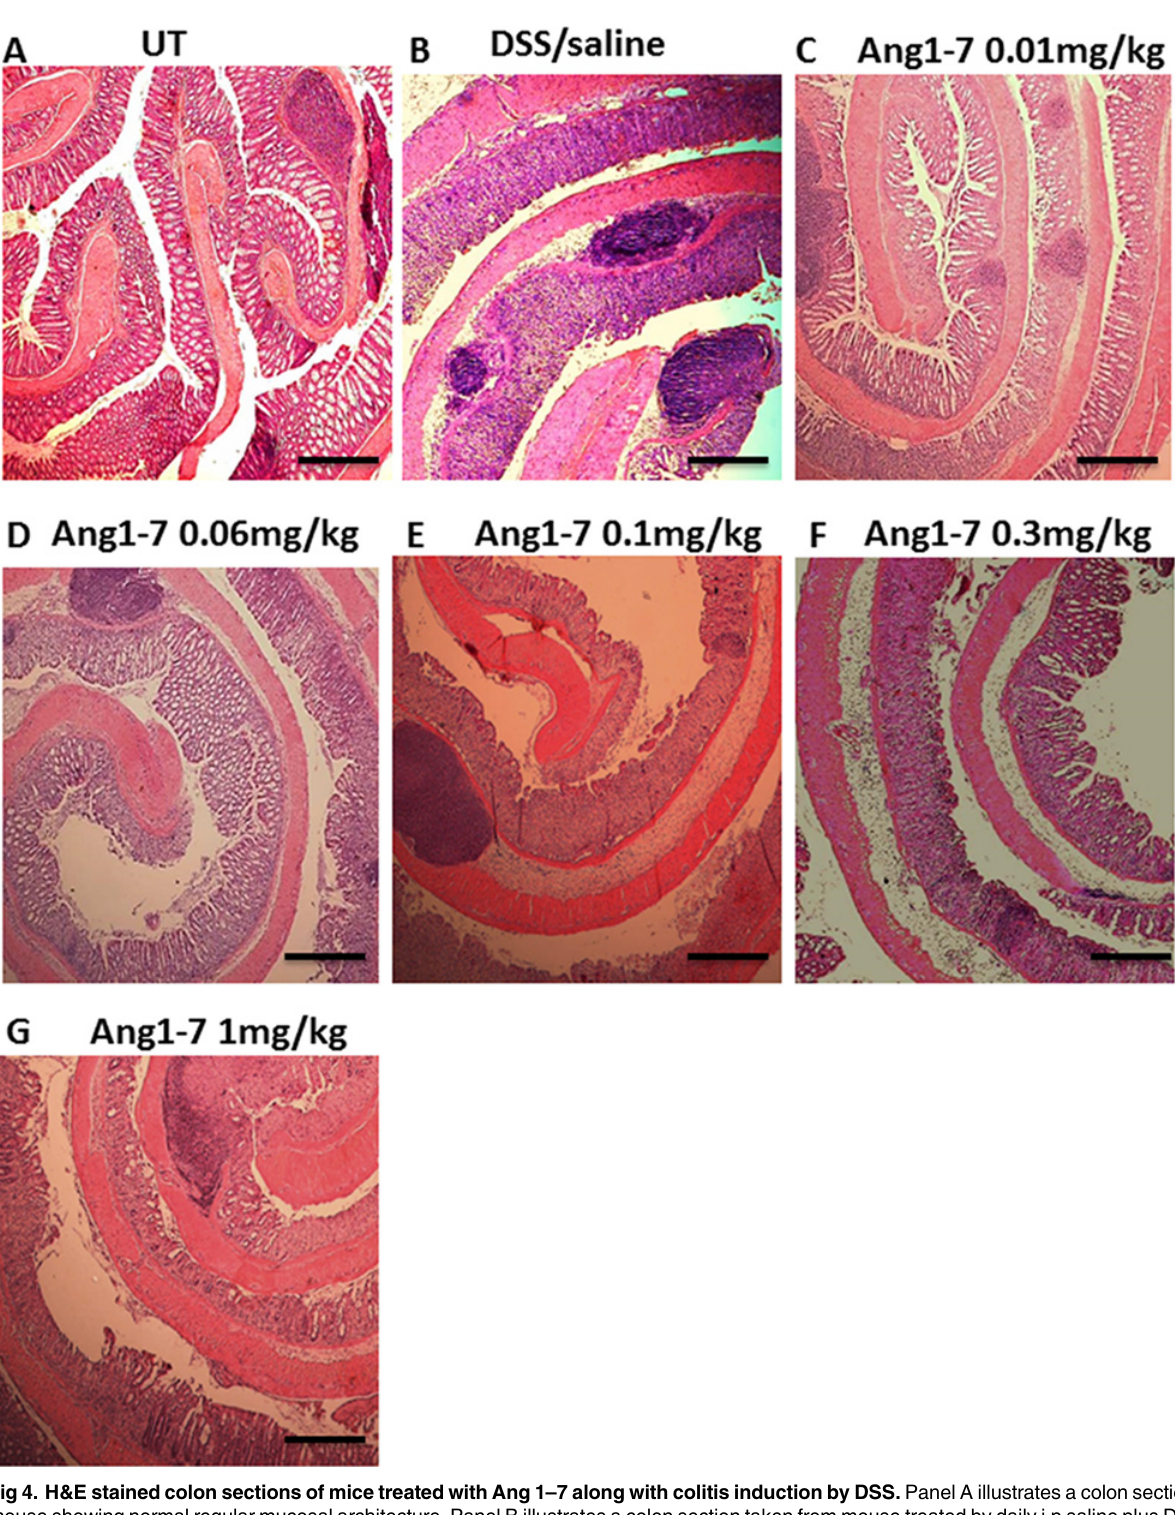
Fig 4. H&E stained colon sections of mice treated with Ang 1 – 7 along with colitis induction by DSS. Panel A illustrates a colon section taken from UT mouse showing normal regular mucosal architecture. Panel B illustrates a colon section taken from mouse treated by daily i.p saline plus DSS where there is significant mucosal destruction and immune cells recruitment. Panels C-G illustrate typical colon sections taken from mice treated with Ang1-7 plus DSS. Treatment with 0.01 – 0.06 mg/kg doses improved mucosal integrity and reduced the enhanced immune cell recruitment (panels C and D). This anti- inflammatory effect of Ang 1 – 7 was lost with higher doses (panels E-G). Bars represent 150 μ